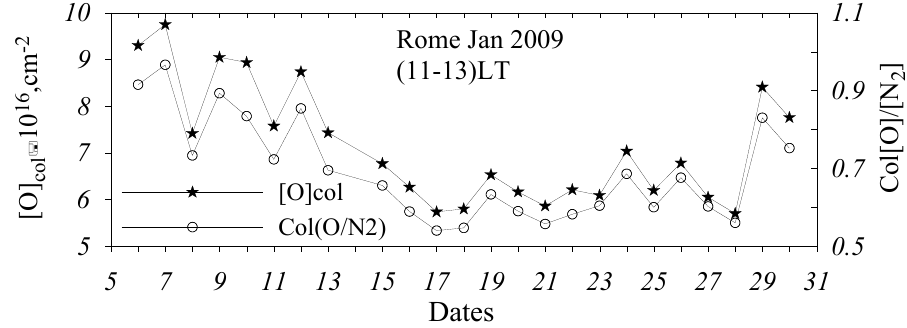
Figure 10. The retrieved column atomic oxygen density and column [O]/[N 2 ] ratio, both in reference to an N 2 column density of 10 17 cm − 2 .